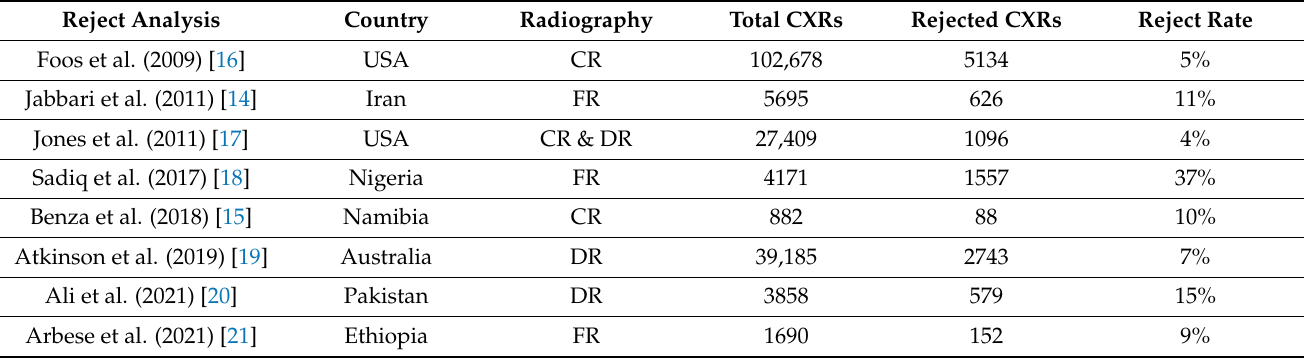
Table 2. Tabular summary of reject rates for CXRs in prior publications. (Key: DR—digital radiography; CR—computed radiography; Conventional—conventional/film radiography; FR— film/conventional